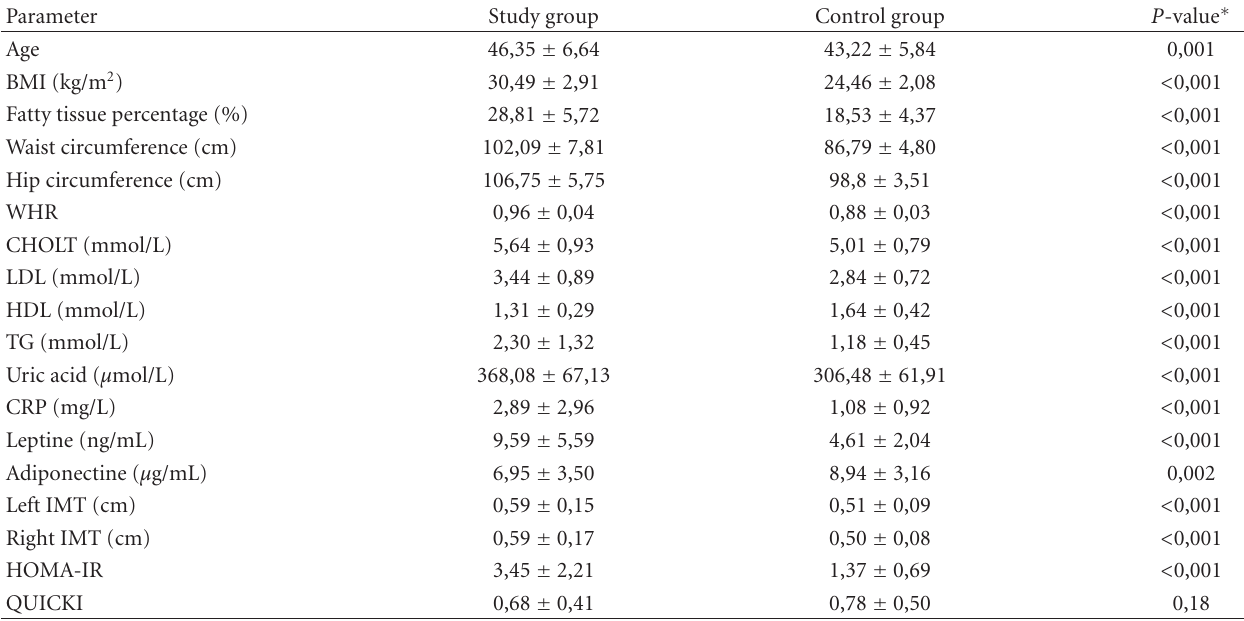
Table 1: Baseline characteristics of study group and control group.